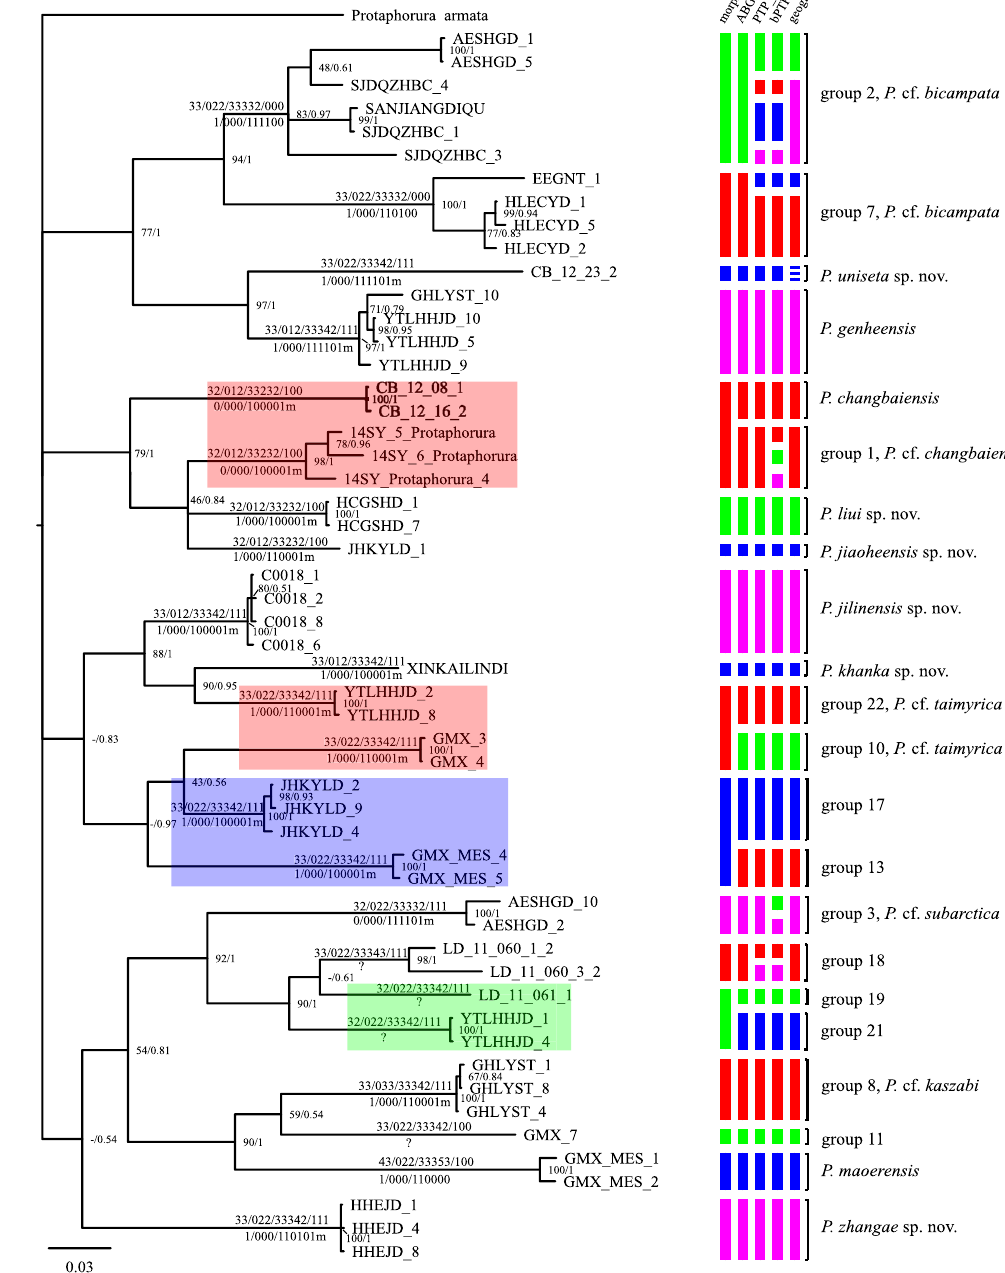
Figure 3. Summary from all species delimitation analyses on a Bayesian consensus tree. Node values represent likelihood bootstrap and posterior probabilities, respectively, with a–indicating nodes not compatible between the analyses. Colored bars represent hypothesized species groupings based on corresponding delimitation analyses. The geographical delimitation indicates the result of threshold of 50 kilometers. Colored clades on phylogeny are taxa morphologically unresolved. Number formulae above and below branches represent dorsal pseudocelli and ventral parapseudocelli,